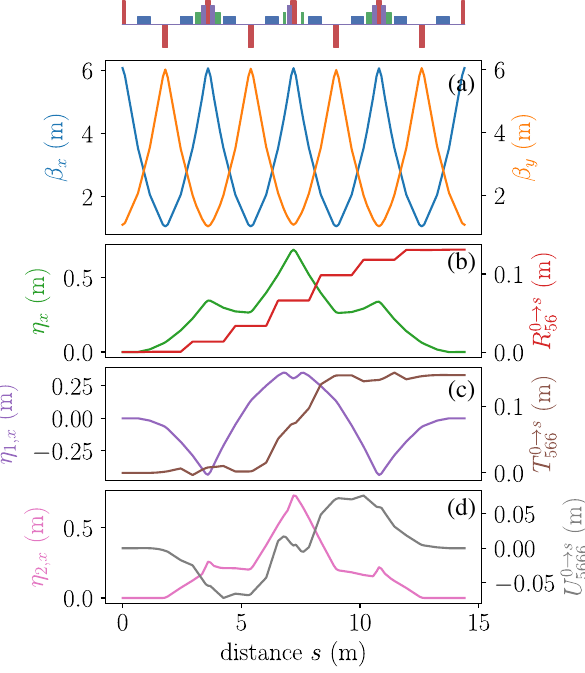
FIG. 10. Layout of bunch compressor BC2 (top diagram) with evolution of associated betatron function (a) and pertinent linear (b), second-order (c), and third-order (d) transfer-map elements along the beam line (with s ¼ 0 corresponding to the beginning of BC2). In plots (b) – (d) the left and right axes refer to the horizontal chromatic functions η and accumulated longitudinal i;x transfer-map elements from 0 to location s along BC2. The top diagram follows the same conventions as in Fig. 9.